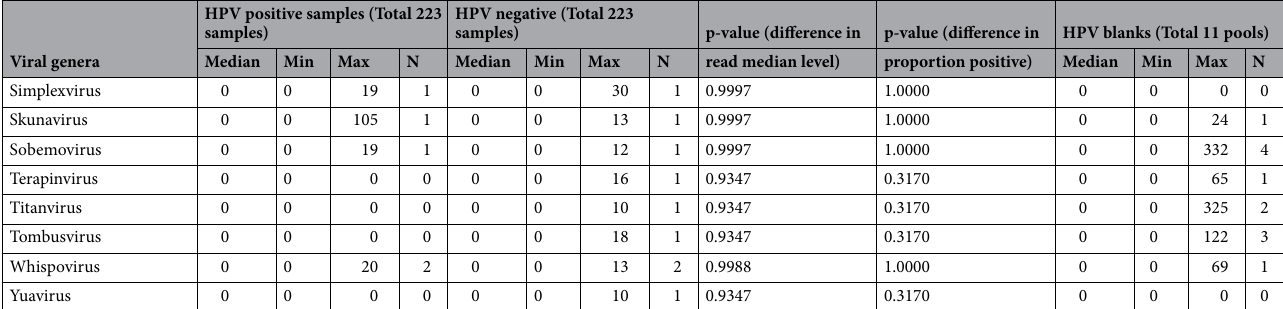
Table 2. Viral genera and annotated reads detected in cervical cancer specimens. Viral genera highlighted in bold correspond to genera presenting a positive median number of annotated reads/sample. Genera are reported when comprising at least 10 reads and being at least 1% of total viral